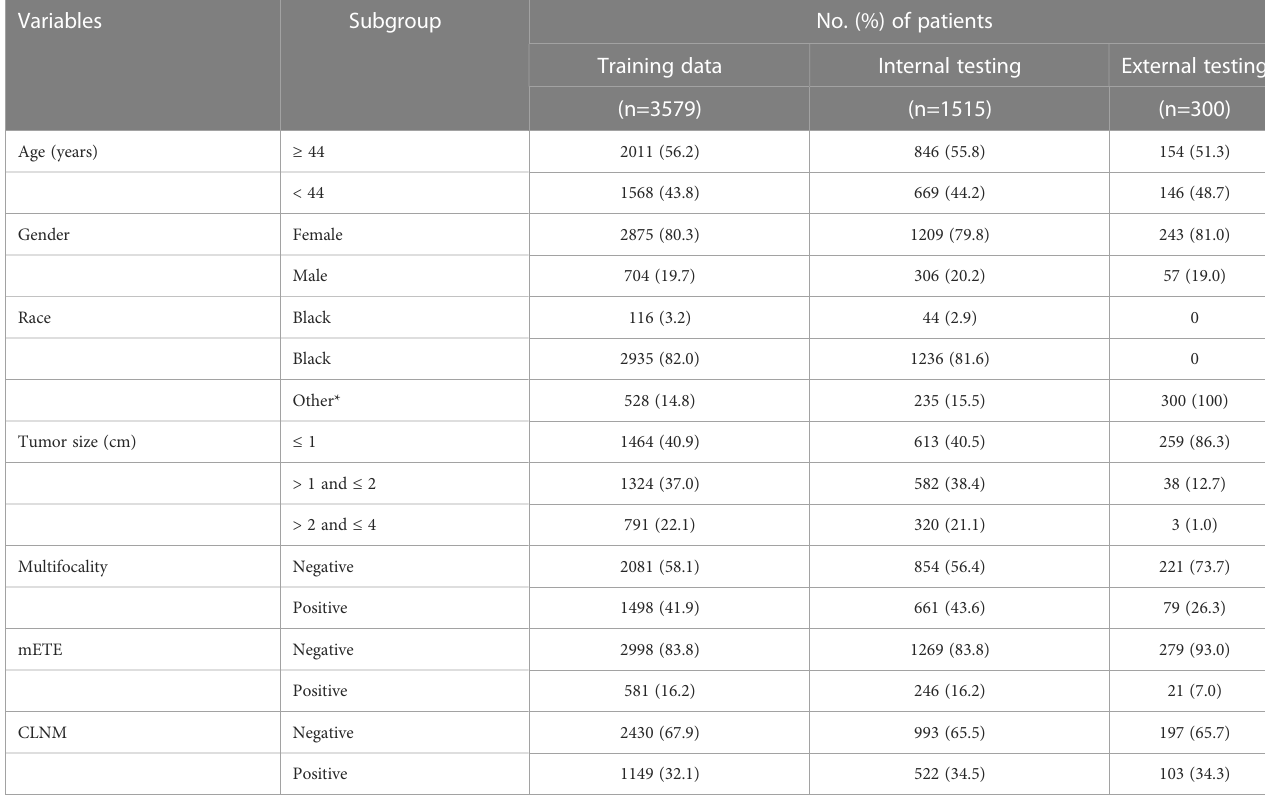
TABLE 1 Clinicopathological characteristics of T1-T2 PTC patients with no